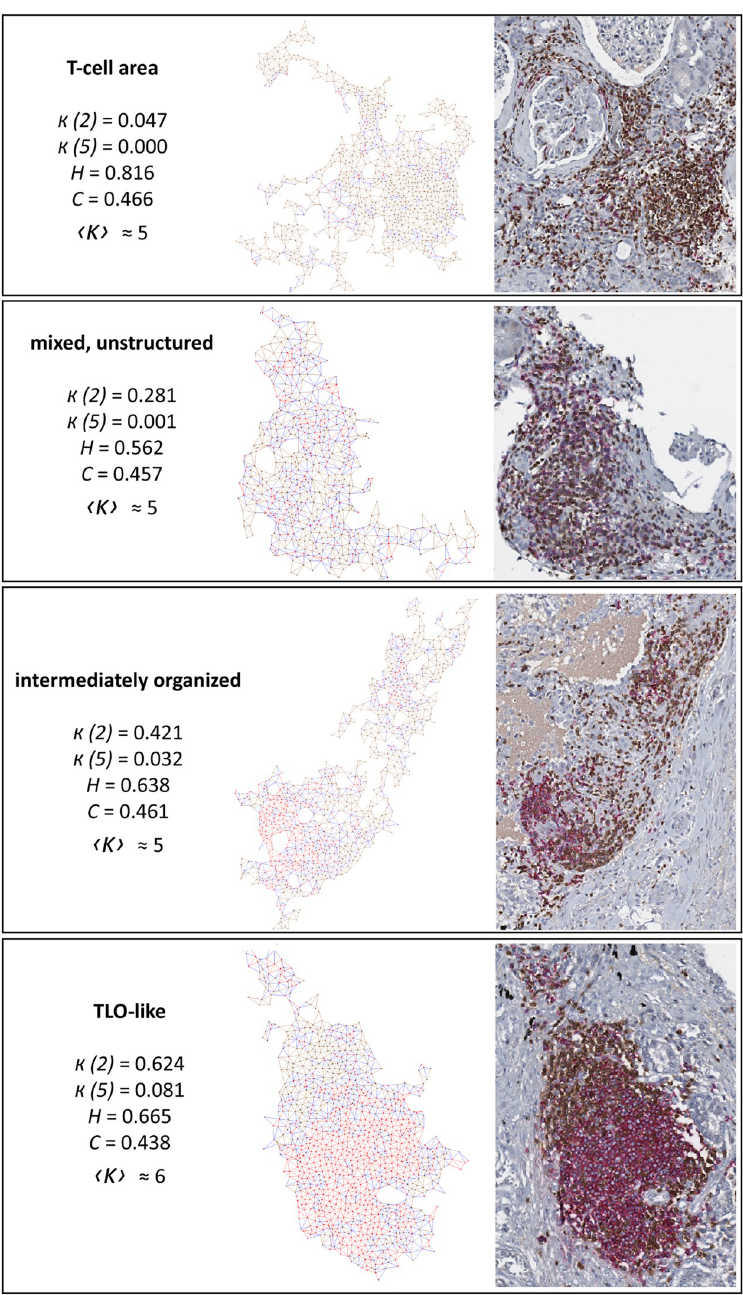
Fig 3. Examples of identified infiltrates. Left: as graph representation. Right: as histological image. T-cells and their links in brown, B-cells in red, edges between T- and B-cells in blue.